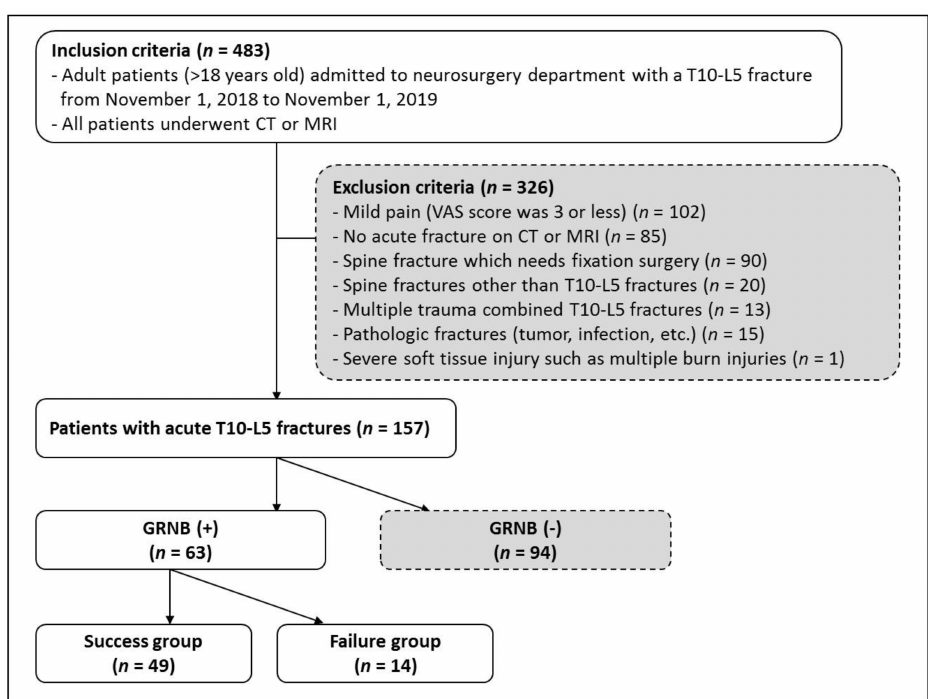
Figure 1. Flow chart of numbers of participants at each stage of study divided into a success group and a failure group. Computer Tomography (CT); Magnetic resonance imaging (MRI); visual analog scale (VAS); gray ramus communicans nerve block